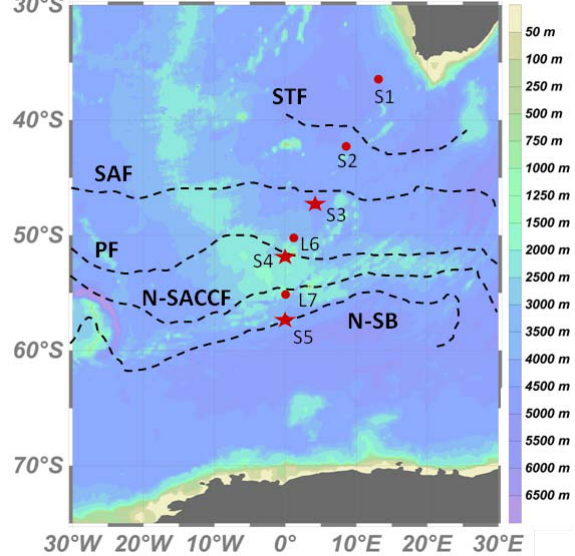
Fig. 1. Map of the study area with bathymetry and fronts (follow- ing Sokolov and Rintoul, 2009, and Swart et al., 2008): STF = SubTropical Front; SAF = SubAntarctic Front (middle branch); PF = Polar Front (middle branch); N-SACCF = northern branch of the Southern ACC front; N-SB = northern branch of the South- ern Boundary (SB). The area north of the STF is the SubTropical Zone (STZ); between STF and SAF the SubAntarctic Zone (SAZ); between the SAF and PF the Polar Front Zone (PFZ); between the PF and SB the Antarctic Zone (AZ), and south of the SB the northern part of the Weddell Gyre (WG). The stations where only the mixed layer was sampled are represented by dots. The stations where water column bSiO 2 samples have been collected are rep- resented by the stars. S refers to “super” stations and L to “large” stations. Mapping from Ocean Data View (Robert Schlitzer, avail- able at